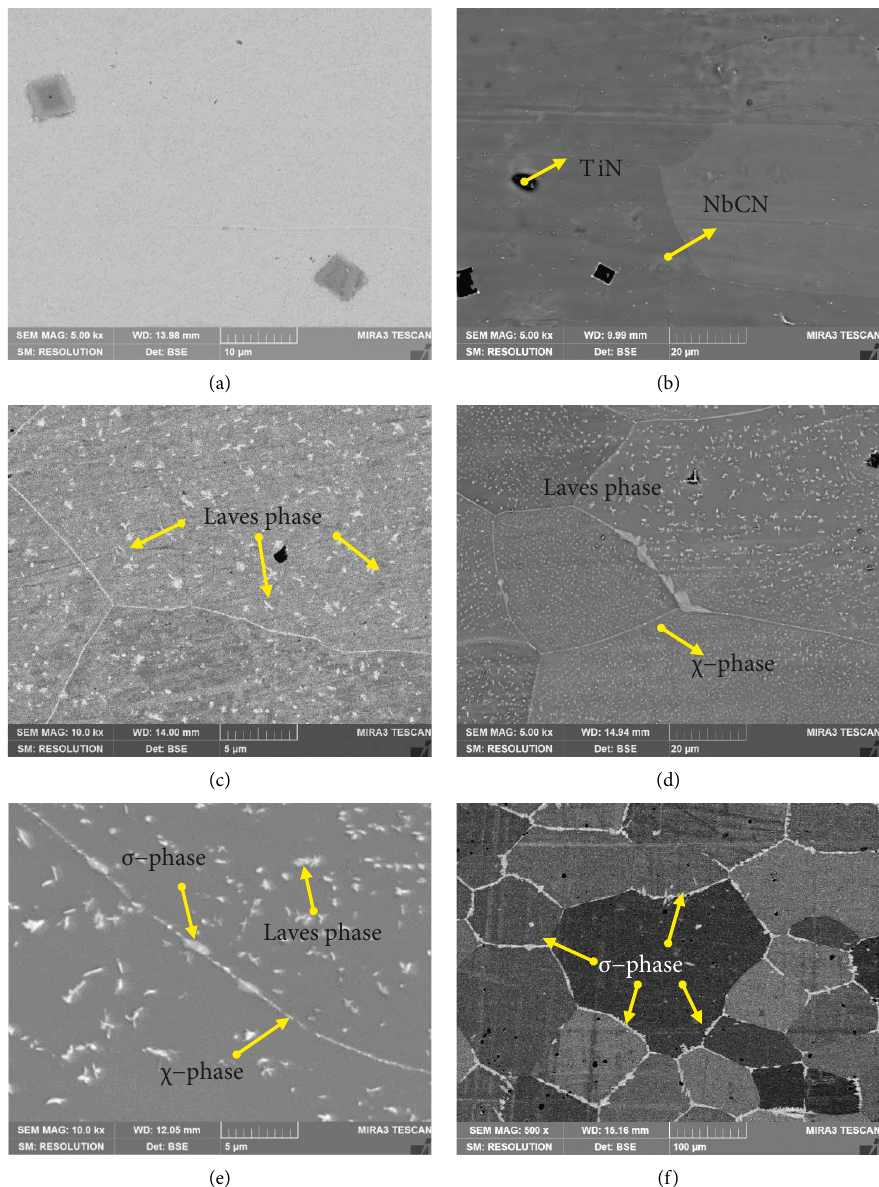
Figure 4: The precipitate morphology of the solution-treated samples after fire simulation treatment at different temperatures: (a) 600 ° C × 1h, (b) 600 ° C × 4 h, (c) 700 ° C × 1h, (d) 700 ° C × 4 h, (e) 800 ° C × 1 h, (f) 800 ° C ×